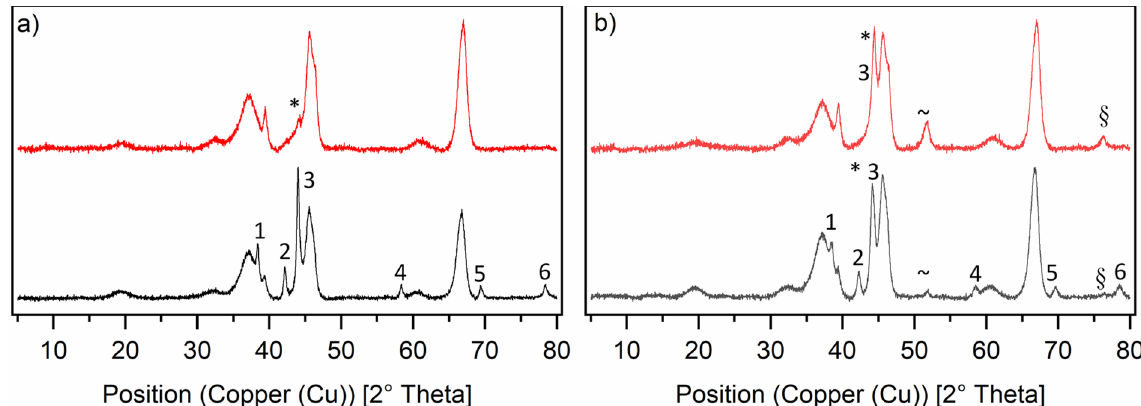
Figure 3. Normalised PXRD diffractograms of the ruthenium-nickel catalysts on γ -Al 2 O 3 in reduced state. Graph ( a ) shows the RuNi-NO-catalysts and Graph ( b ) shows the RuNi-Cl-catalysts. The black lines show the RuNi-XX-icr. catalysts and the red lines show the RuNi-XX-ir. catalysts. The nickel phases are marked in the diffractograms as follows: * = 111, ~ = 200, § = 220. The ruthenium phases are marked in the diffractograms as follows: 1 = 100, 2 = 002, 3 = 101, 4 = 102, 5 = 110, 6 = 103.